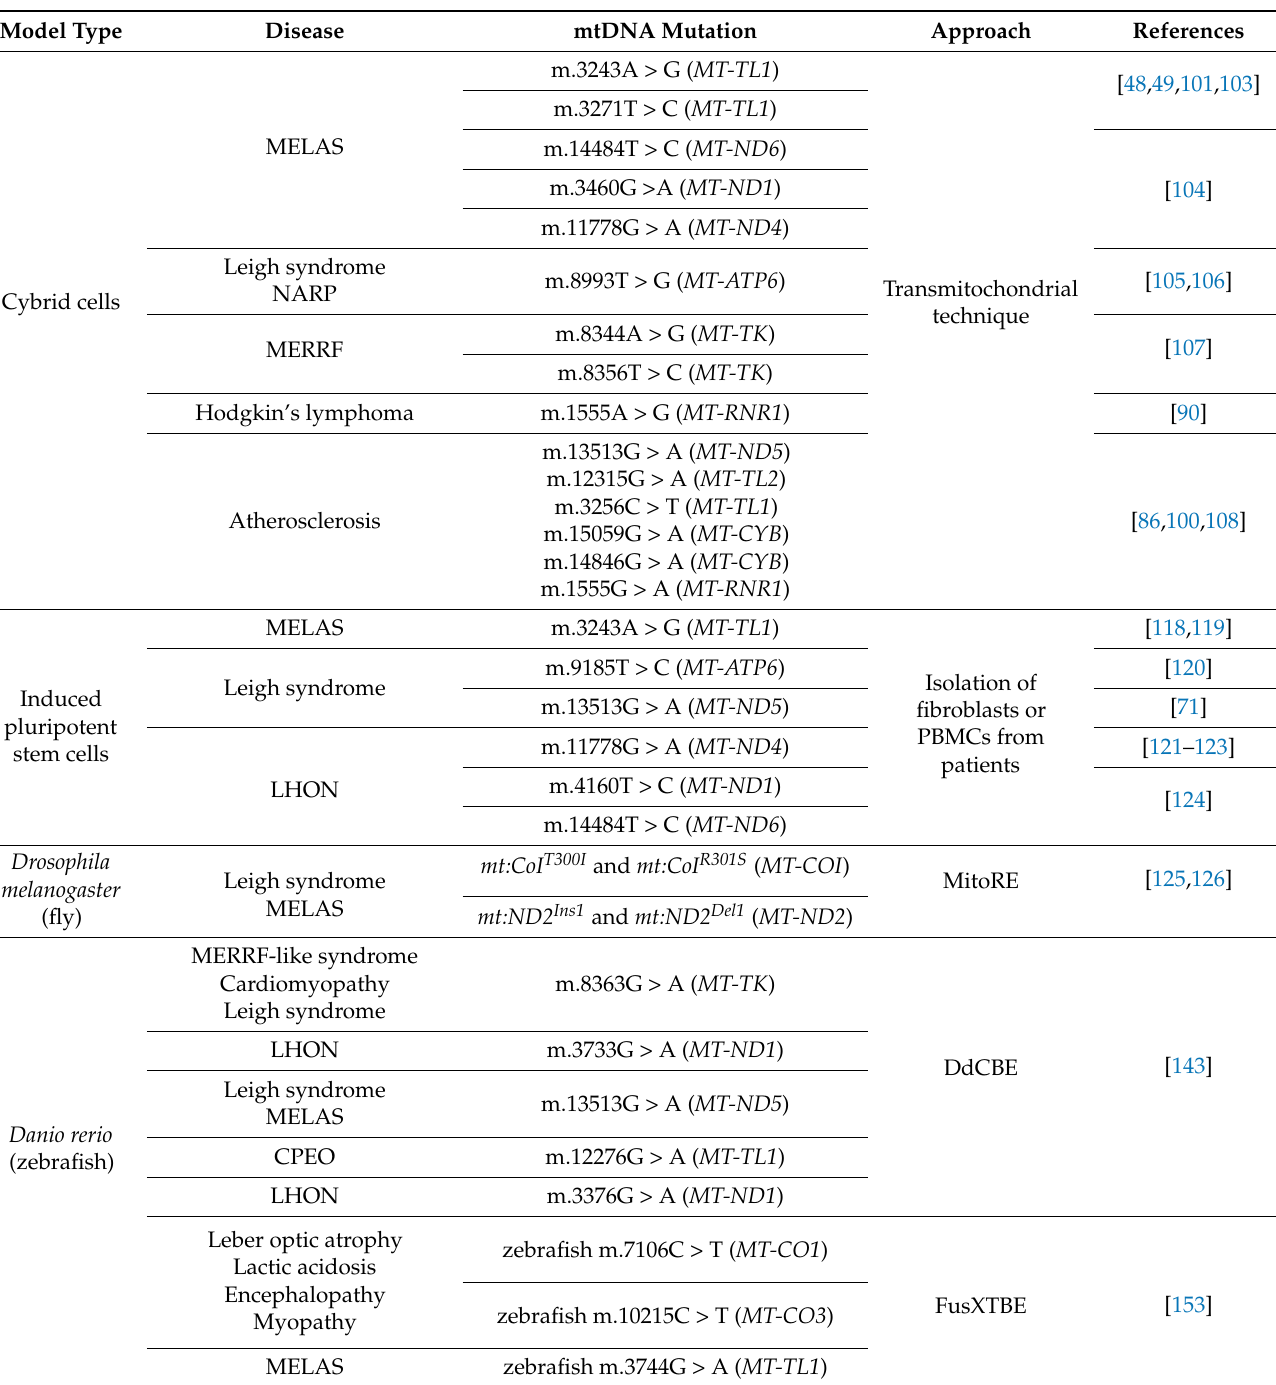
Table 3. Animal and cell models of diseases associated with mtDNA